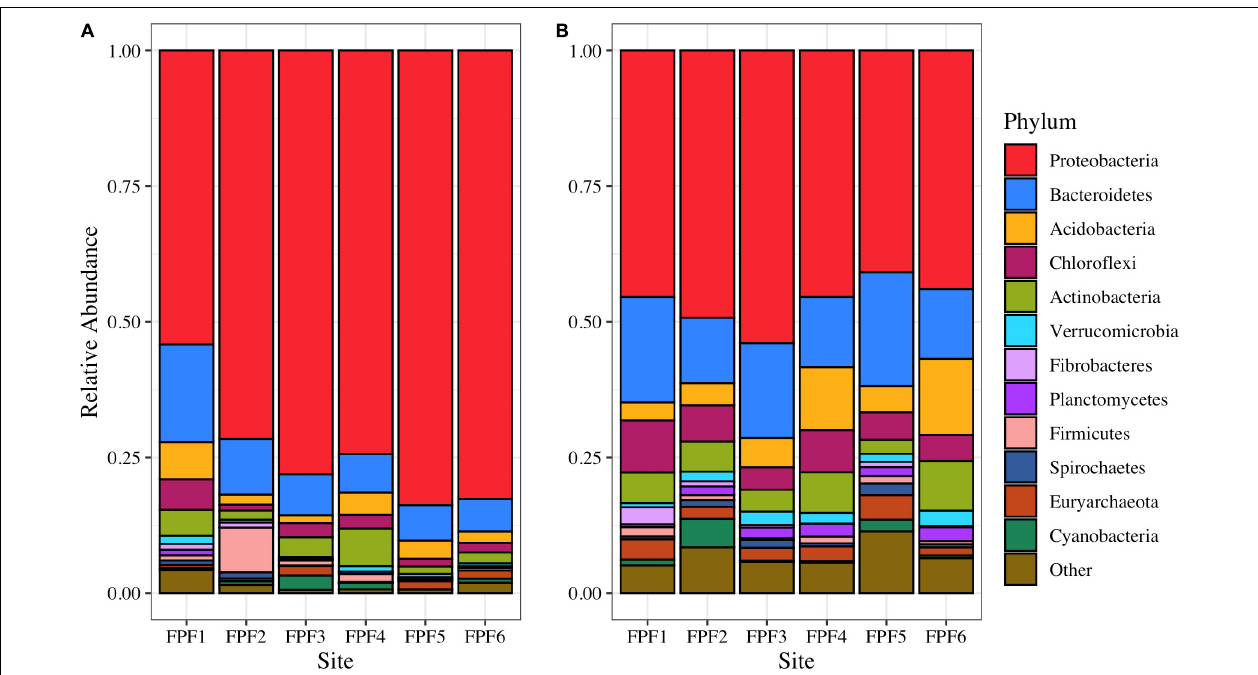
FIGURE 1 | Microbial community structure based on 16S rRNA amplicon reads in Frozen Pond Fen in (A) 2016 and (B) 2018. Phylum level taxonomy is displayed, and the top 12 phyla are presented. Phyla with relative abundances < 2% are grouped into